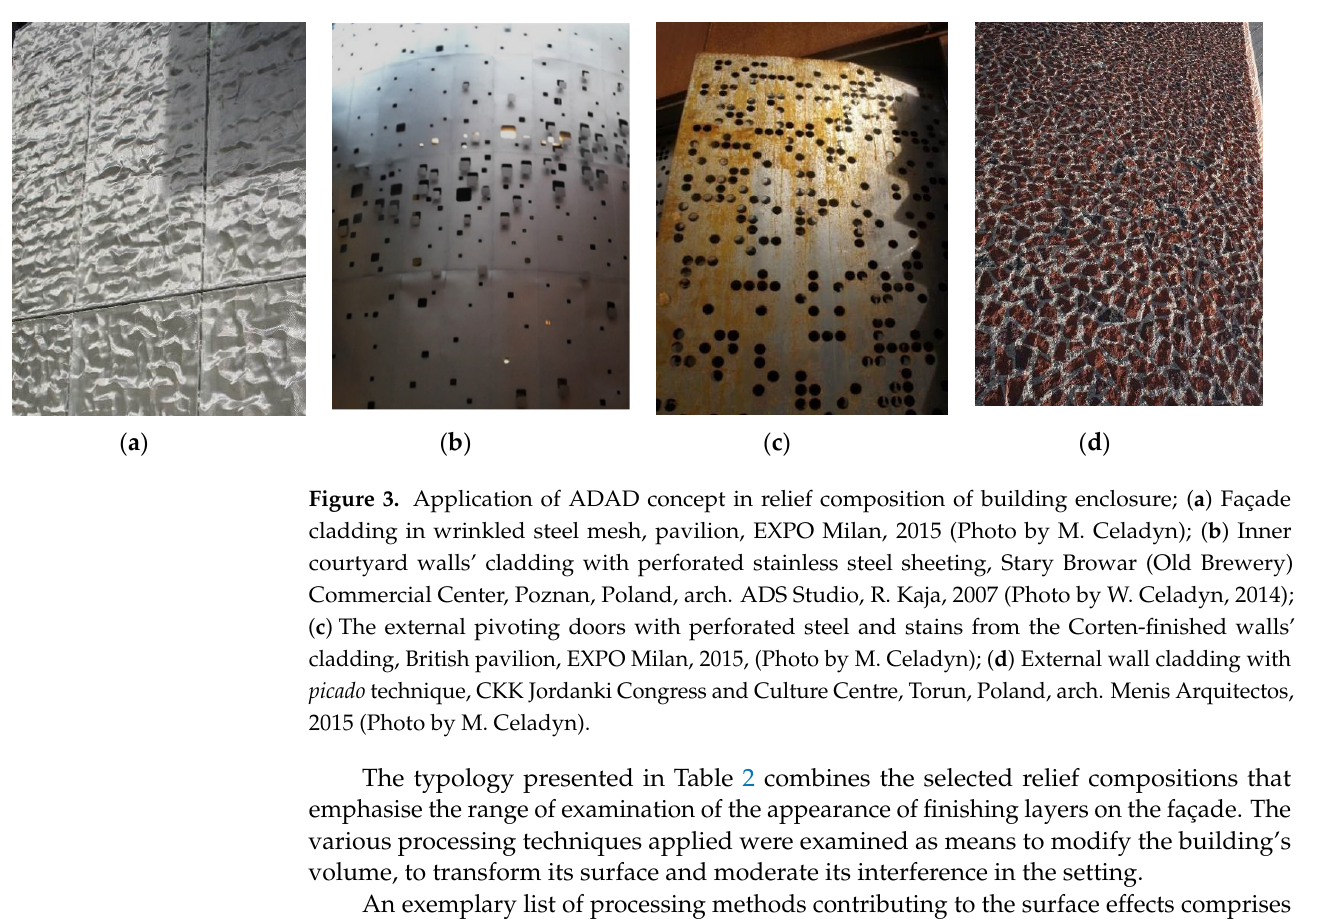
Table 2. Typology of relief composition in the ADAD concept.